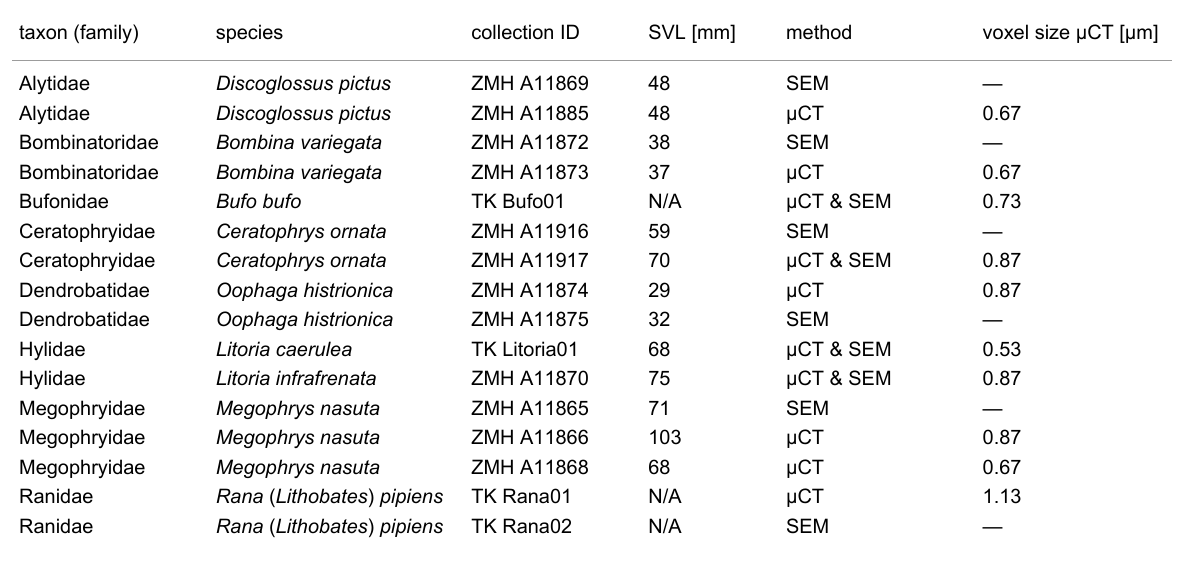
Table 1: Specimens examined